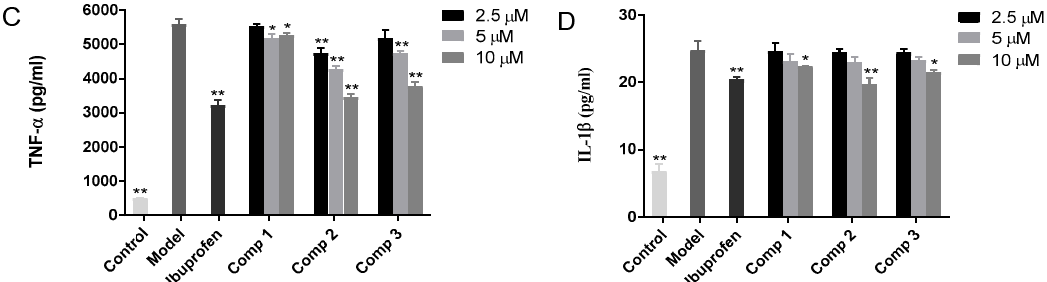
Figure 2. ( A ) The cytotoxicity of the compounds against mouse macrophage cells (RAW 264.7). ( B ) The effects of the compound on the release of NO from RAW 264.7 cells (LPS-activated). ( C ) The effect of the compound on the release of TNF- α from RAW 264.7 cells (LPS-activated), while ( D ) indicates the effect of the compound on the release of IL-1 β from RAW 264.7 cells (LPS-activated). The stimulation of RAW 264.7 cells was carried out with 2 µg per mL of LPS in the presence of the compounds, while the compounds were not present in the control. Griess and ELISA methods were employed for the evaluation of the secreted level of NO, TNF- α , and IL-1 β in the supernatants, post overnight stimulation of LPS. * p < 0.05, ** p < 0.01 was compared to the model.